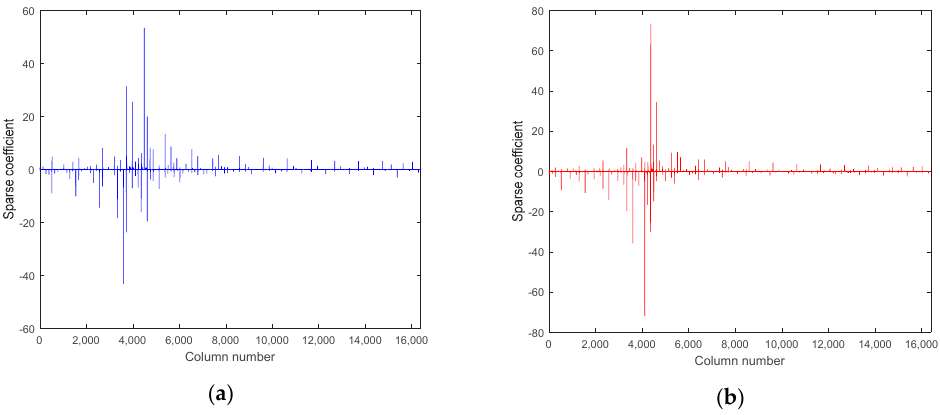
Figure 7. Sparse coefficients of two current signals ( a ) Normal current; ( b ) Fault current.